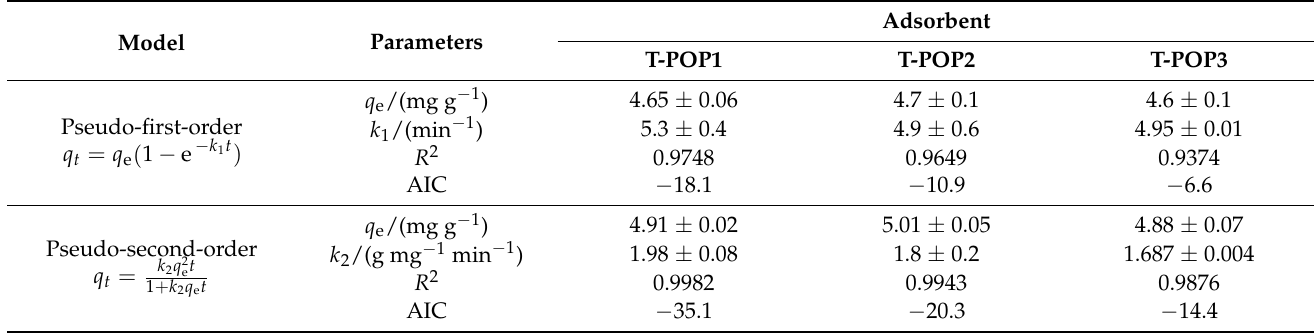
Figure 8. MO adsorption kinetics on different polymers at 25 °C, starting from a 10 mg L − 1 dye solution. The dashed lines represent the fit of the pseudo-second-order equation. Table 3. Fitting parameters of different kinetic models for MO adsorption.